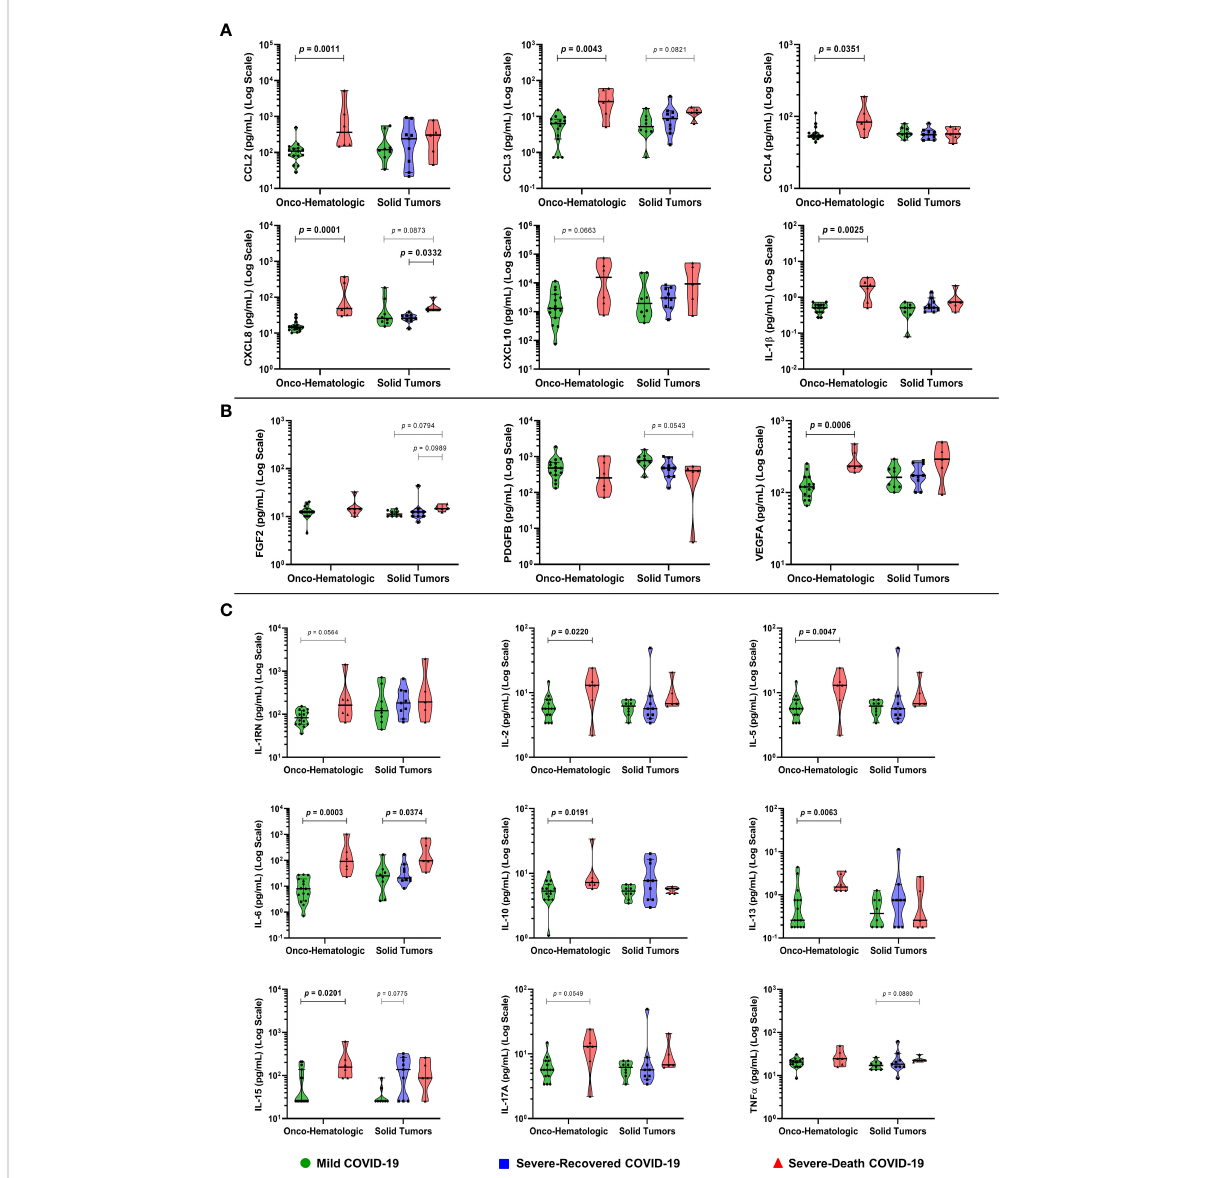
FIGURE 3 Patients with hematologic malignancies and COVID-19 that display an exacerbated soluble immune pro fi le develop severe disease culminating in death. Blood samples were collected within two days (median; 1 – 4 CI) of the positive SARS-CoV-2 diagnostic and analyzed for 27 immune mediators, being them recruitment factors (A) , growth factors (B) , and cytokines (C) . Groups were de fi ned based on disease severity, as Mild (green), Severe-Recovered (blue), or Severe-Death (red), as described. Data is presented as median plus 95% con fi dence intervals and was analyzed with Kruskal-Wallis adjusted for multiple comparisons followed by Dunn ’ s post-hoc test or Mann-Whitney test. All exact p -values below 0.1 are shown. IL-1RN, Interleukin 1 Receptor Antagonist. N = 21 for Onco-hematologic and N = 22 for Solid Tumors